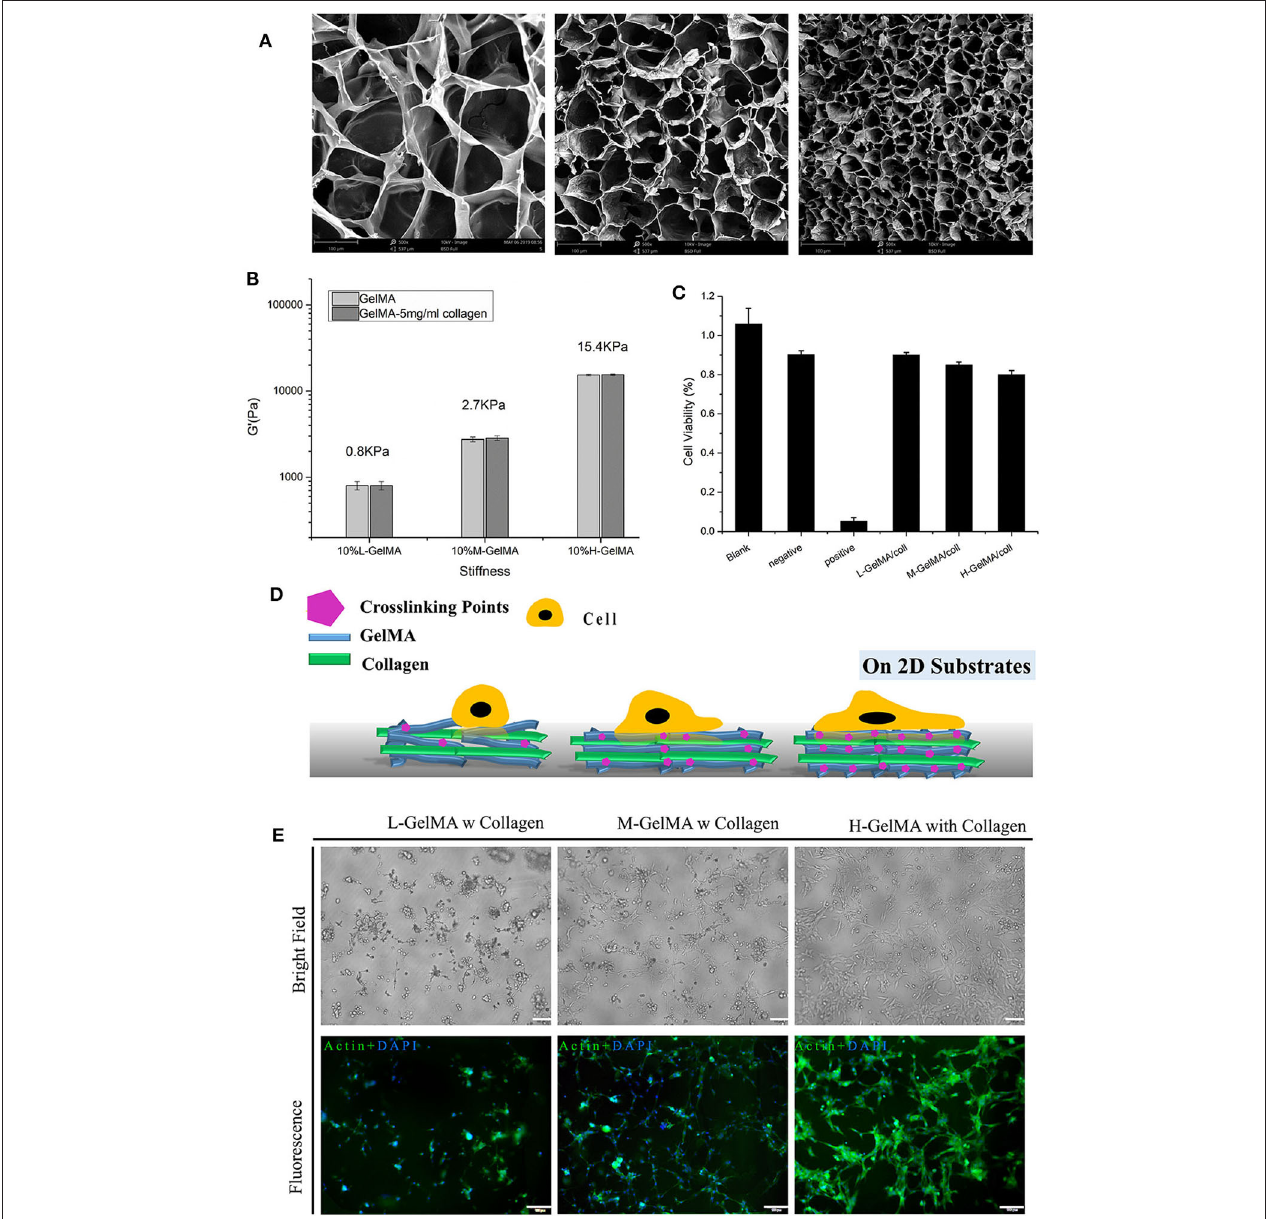
FIGURE 2 | Mechanical properties of composite hydrogel. (A) SEM images of GelMA hydrogels, showing the effect of the degree of methacryloyl substitution on the ore sizes of GelMA hydrogels.; (B) three different degree of methacryloyl substitution of GelMA/collagen hydrogels were fabricated and collagen content was varied from 0 to 5 mg/ml, Despite variations in collagen content, under the same DS of GelMA, the stiffness of composite hydrogel was not significantly different. (C) Cell viability measured with different hydrogels, measured by MTT assay. (D) Schematic illustration of cell attachment on Composite hydrogel with different stiffness. (E) Morphology of C2C12 on 10% GelMA with different degree of substitution, I: L-G + C II: M-G + C III: H-G + C. N = 3 for each experiment. Error bars indicate the S.E.M of the data variation. Scale Bar, 100 µ